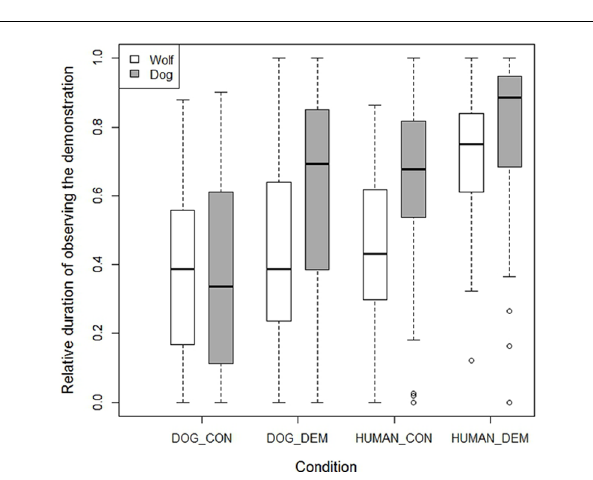
FIGURE 6 | Box plots showing the relative duration that the wolves and dogs observed the various demonstrations. Boxes represent the interquartile range, bars within shaded boxes are median values, whiskers indicate the 5th and 95th percentiles, and open circles are